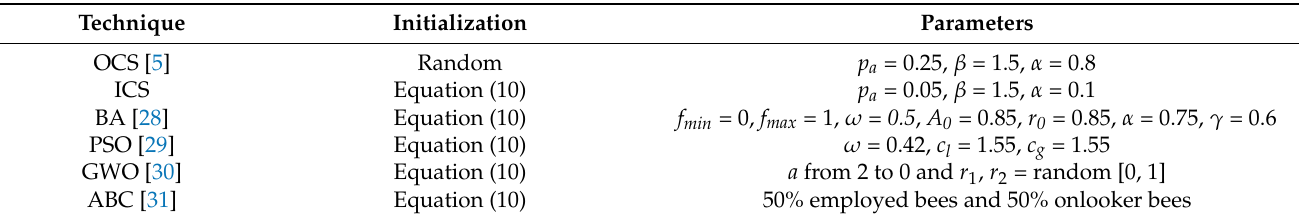
Table 1. The Control Parameters of the Optimization Techniques Used in This Study.